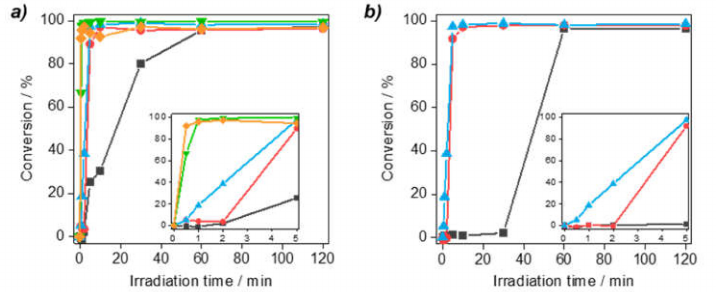
Figure 1. Conversion dependency of the irradiation time during film curing: ( a ) at a set loading of 2,4,5,6-tetrakis(diphenylamino)-1,3-benzenedicarbonitrile (4-DP-IPN) of 50 ppm and different concentrations of diethyl 2-bromo-2-methylmalonate (DBM) (gray squares: 0 mol%, red circles: 0.05 mol%, sky blue triangles: 0.1 mol%, green inverted triangles: 0.5 mol%, and orange diamonds: 5 mol%) and ( b ) at a set concentration of DBM of 0.1 mol% and different loadings of 4-DP-IPN (gray squares: 2 ppm, red circles: 10 ppm, and sky blue triangles: 50